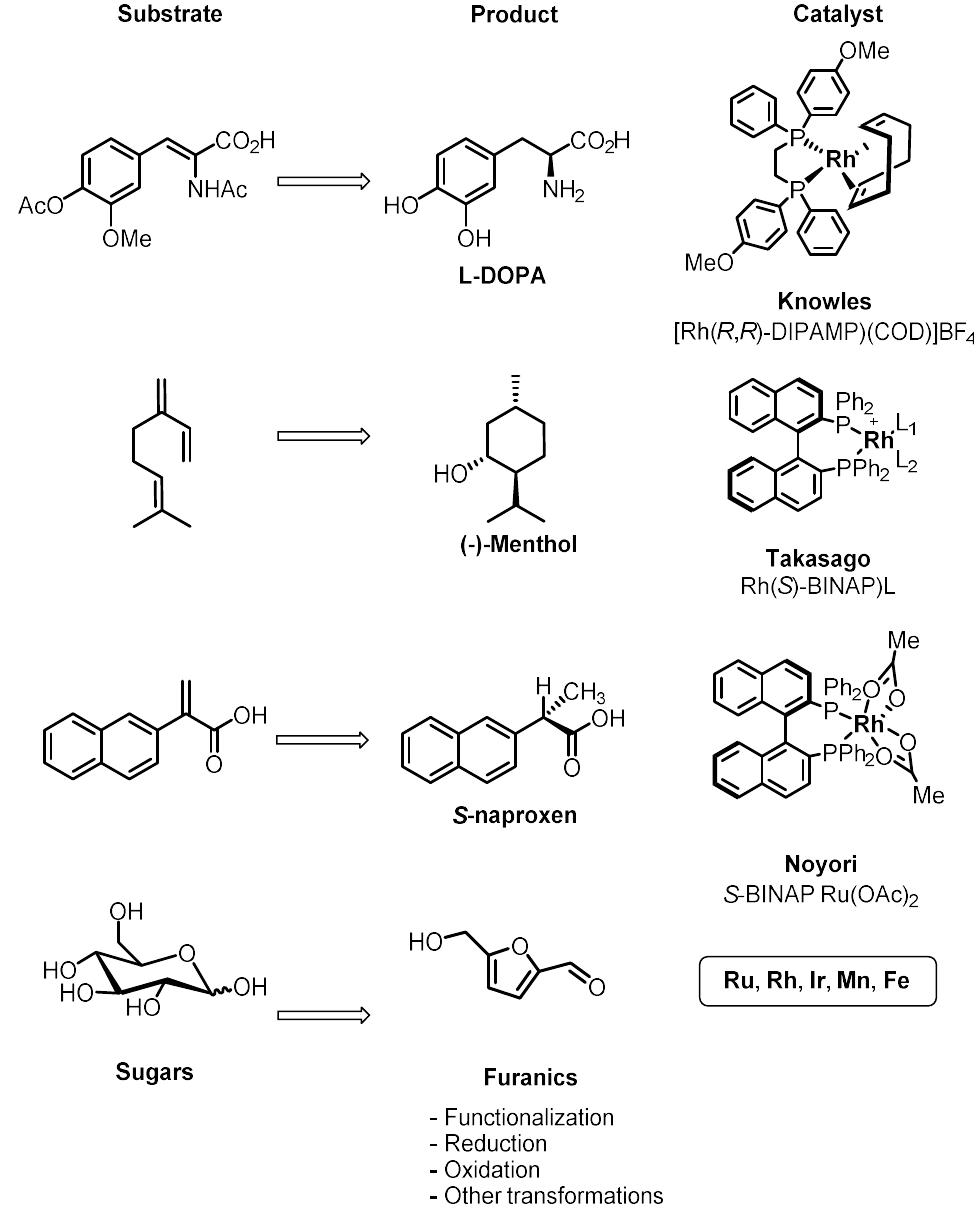
Figure 2. Examples of homogeneous catalyzed processes in industry.